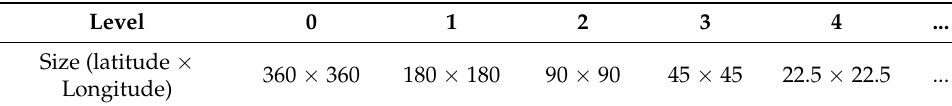
Table 4. The size of vector tiles corresponding to each level in the VTPM.